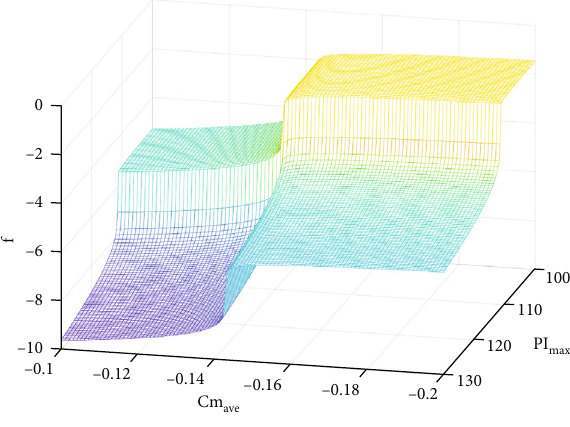
Figure 3: Objective